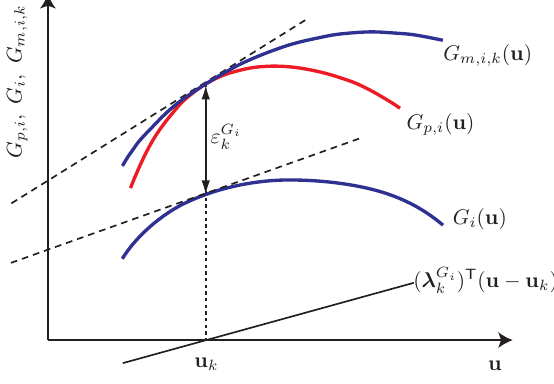
Figure 1. First-order modification of the constraint G i at u k .